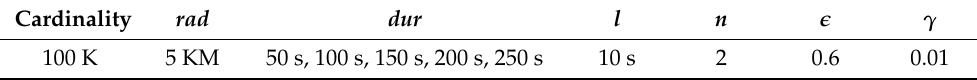
Table 4. Setting of synthetic data parameters and algorithm parameters in duration experiment.